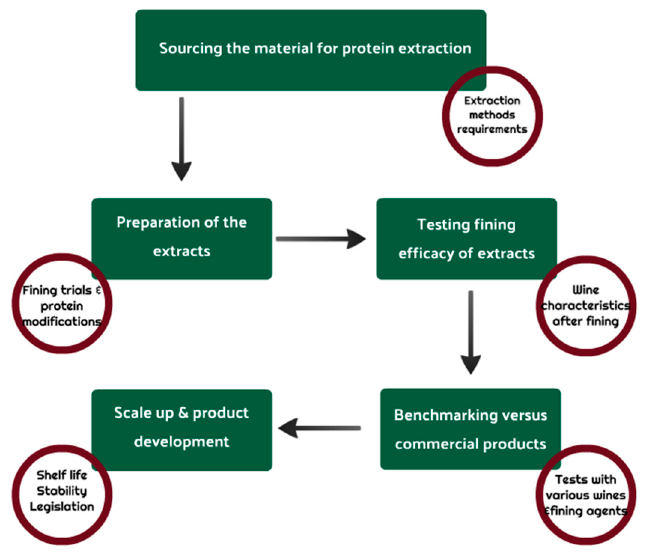
Figure 2. Schematic representation of the key steps required for the development of novel plant protein fining